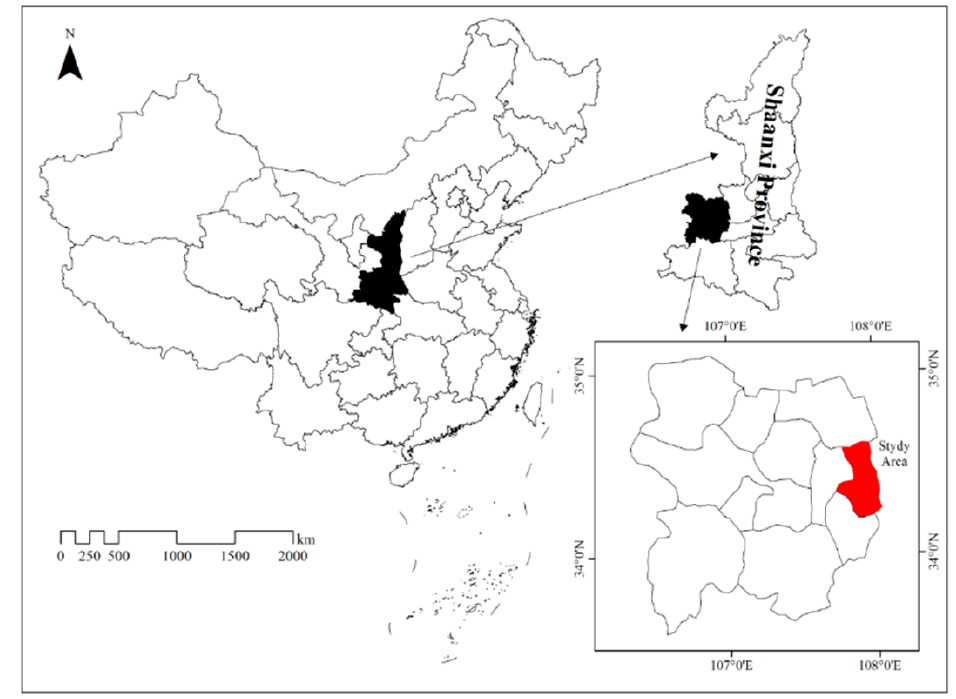
Figure 1. Study area in this study.